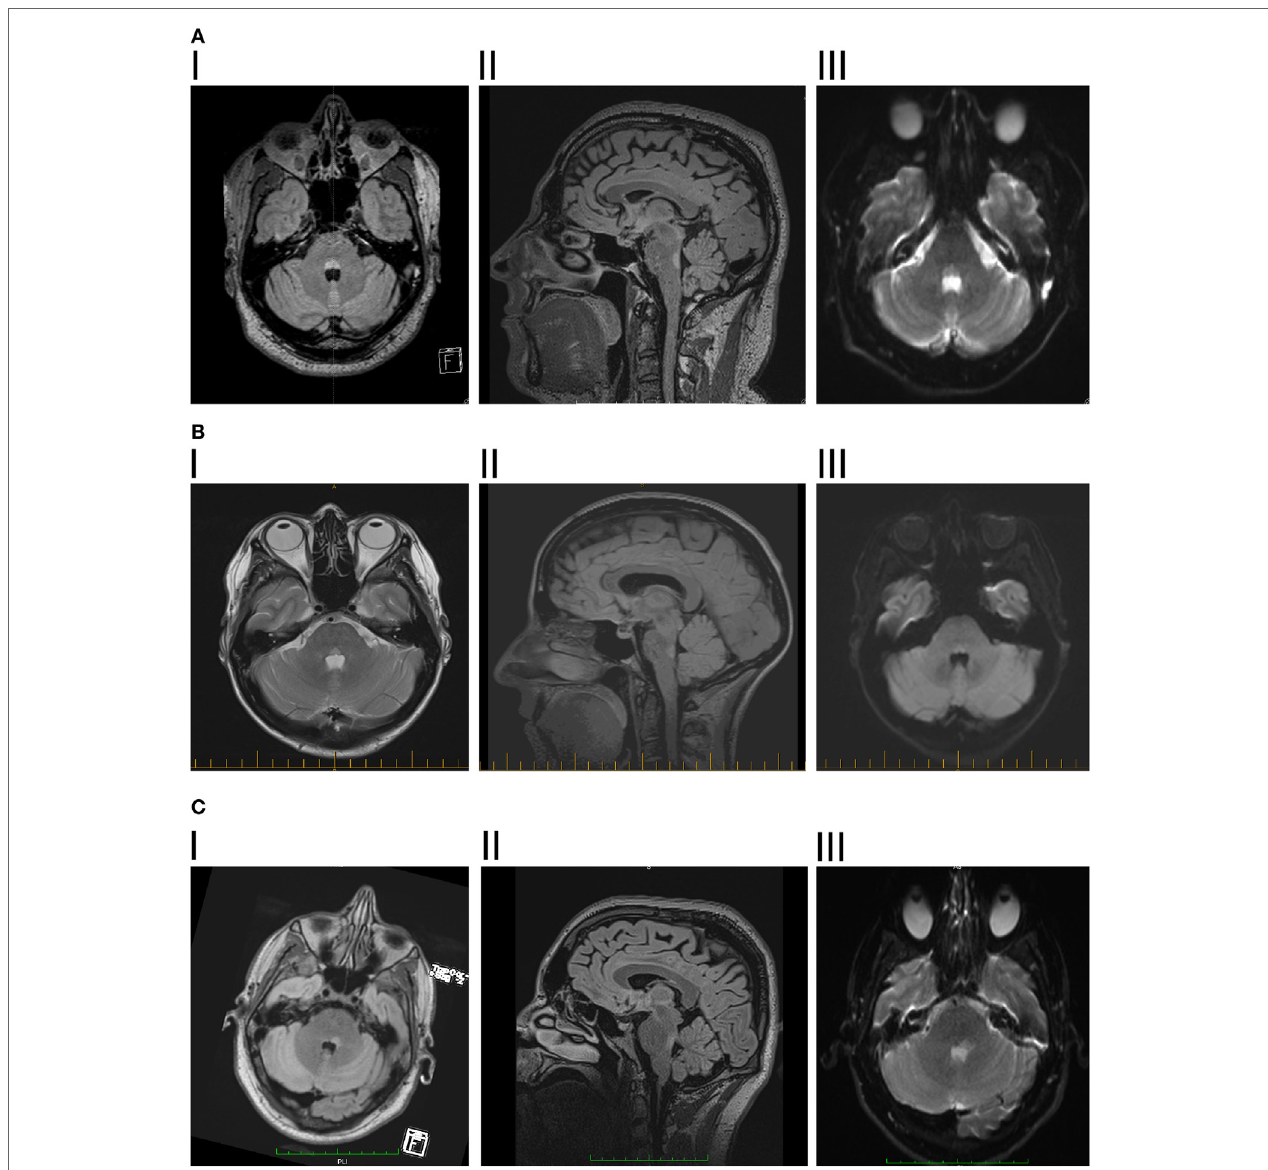
FIGURe 1 | (a) I. Patient 1, axial fluid-attenuated inversion recovery (FLAIR) showing hyperintense lesion in posterior pontine tegmentum. II. Saggital FLAIR showing vertical extent of the lesion. III. Diffusion-weighted imaging showing mild diffusion restriction. (B) I. Patient 2, axial dual showing hyperintense lesion in posterior pontine tegmentum. II. Saggital FLAIR showing vertical extent of the lesion. III. Diffusion-weighted imaging showing mild diffusion restriction. (C) I. Patient 3, axial flair showing hyperintense lesion in posterior pontine tegmentum, slightly more significant on the right side. II. Saggital FLAIR showing vertical extent of the lesion, slightly larger than the previous two patients, consistent with there being some slowing of vertical saccades. III. Diffusion-weighted imaging showing mild diffusion